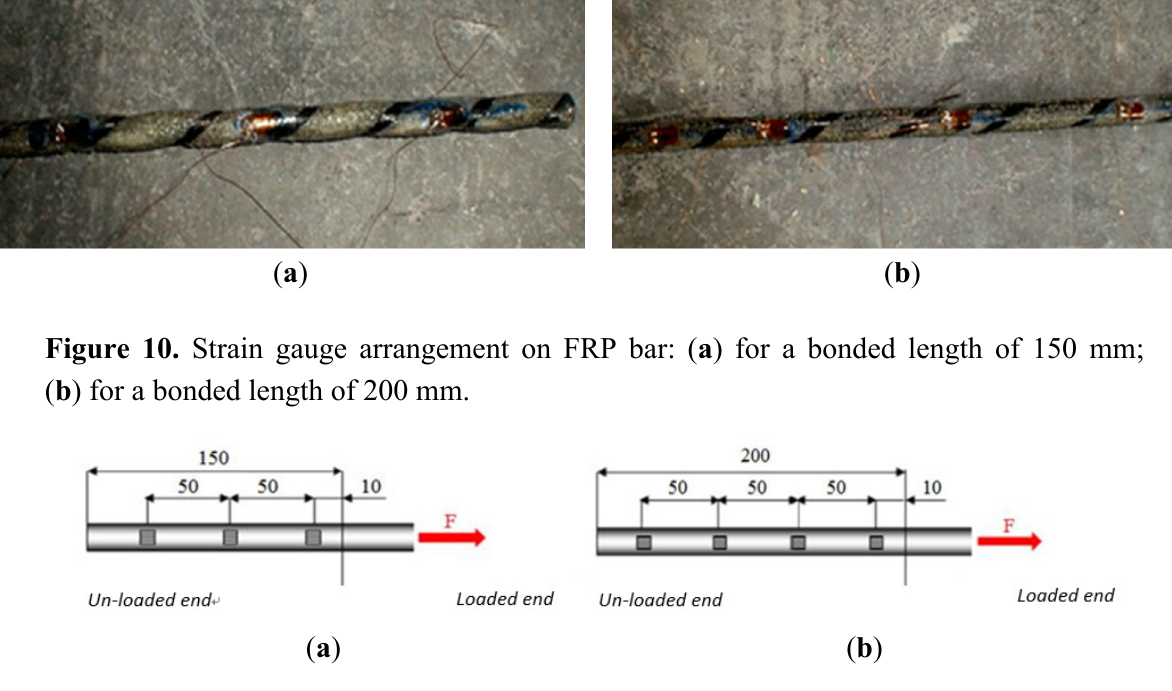
Figure 11. ( a ) Strain gauge arrangement along reinforcement (150-mm bonded length); ( b ) strain gauge arrangement along reinforcement (200-mm bonded